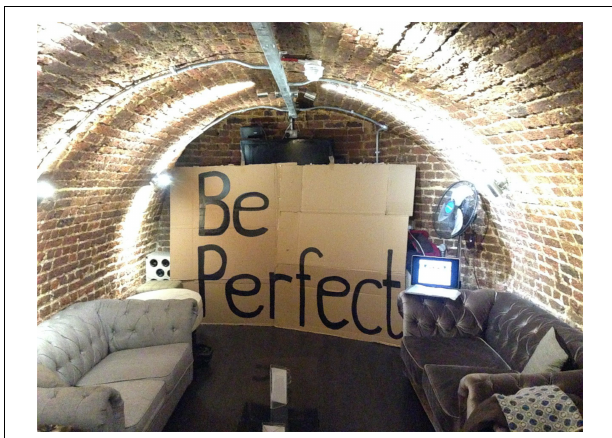
FIGURE 1 | Image of meeting space from the Secret Society of Imperfect Nurses. Anthony Schrag.